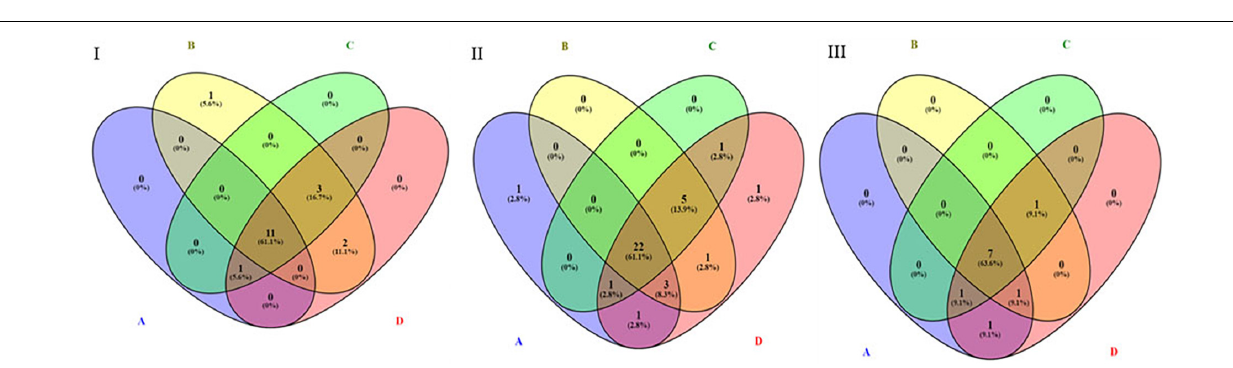
FIGURE 5 | Venn diagram representing the distribution of downregulated miRNAs in various pharmacogenomic pathways. A – ABC transporters, B – drug metabolism cytochrome P450, C – drug metabolism other enzymes, D – metabolic pathways. (I) Downregulated in 25 µ M HLP vs. control, (II) Downregulated in 25 µ M CLZ vs. control, (III) Downregulated in 25 µ M HLP + 25 µ M CLZ vs.